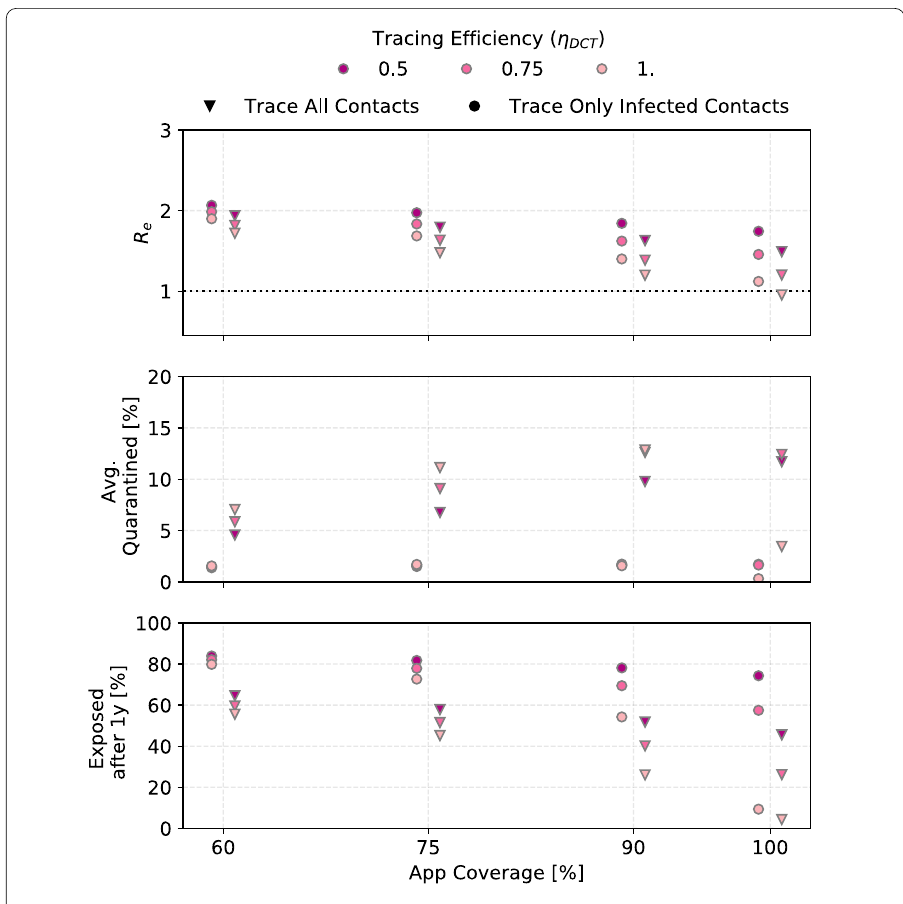
Figure 9 The effect of the tracing probability η DCT for different app coverages ( R 0 = 3, α · f m =